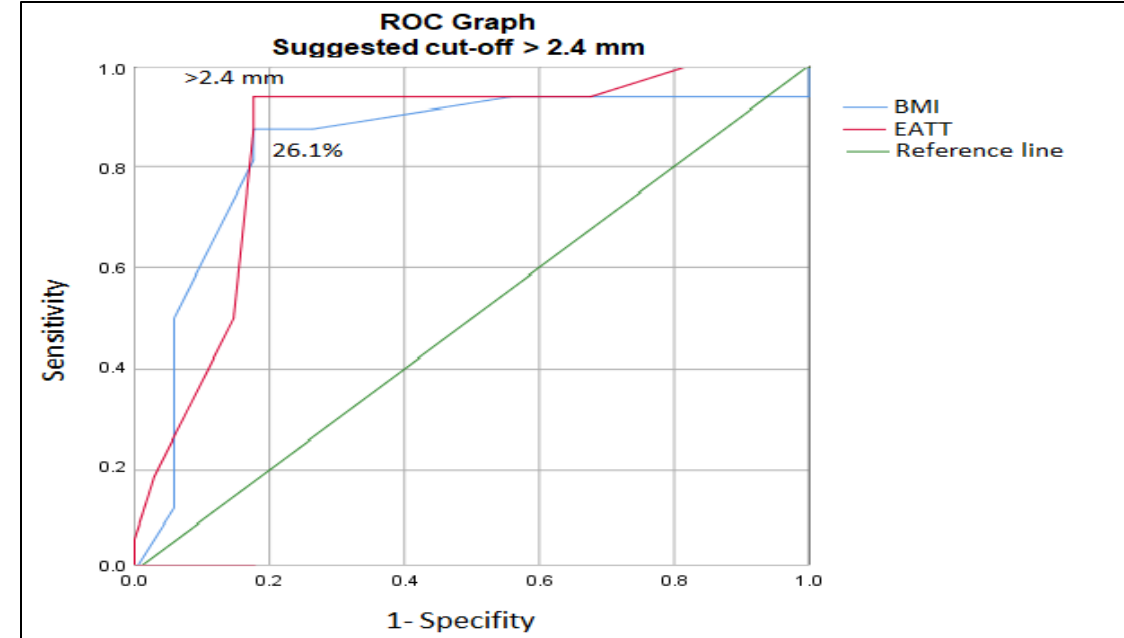
Figure 1. ROC graph suggested cut off>2.4 mm .Predictive ROC Curve of not response to thrombolysis therapy using epicardial adipose tissue thickness and body mass